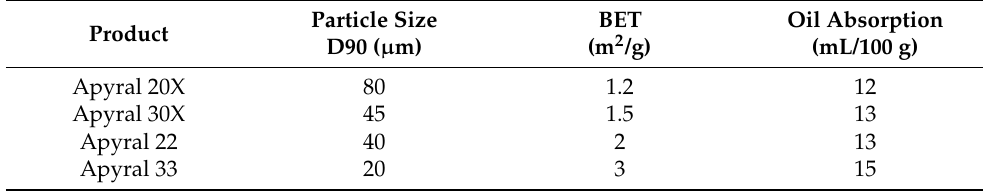
Table 1. Flame-retardant fillers features.